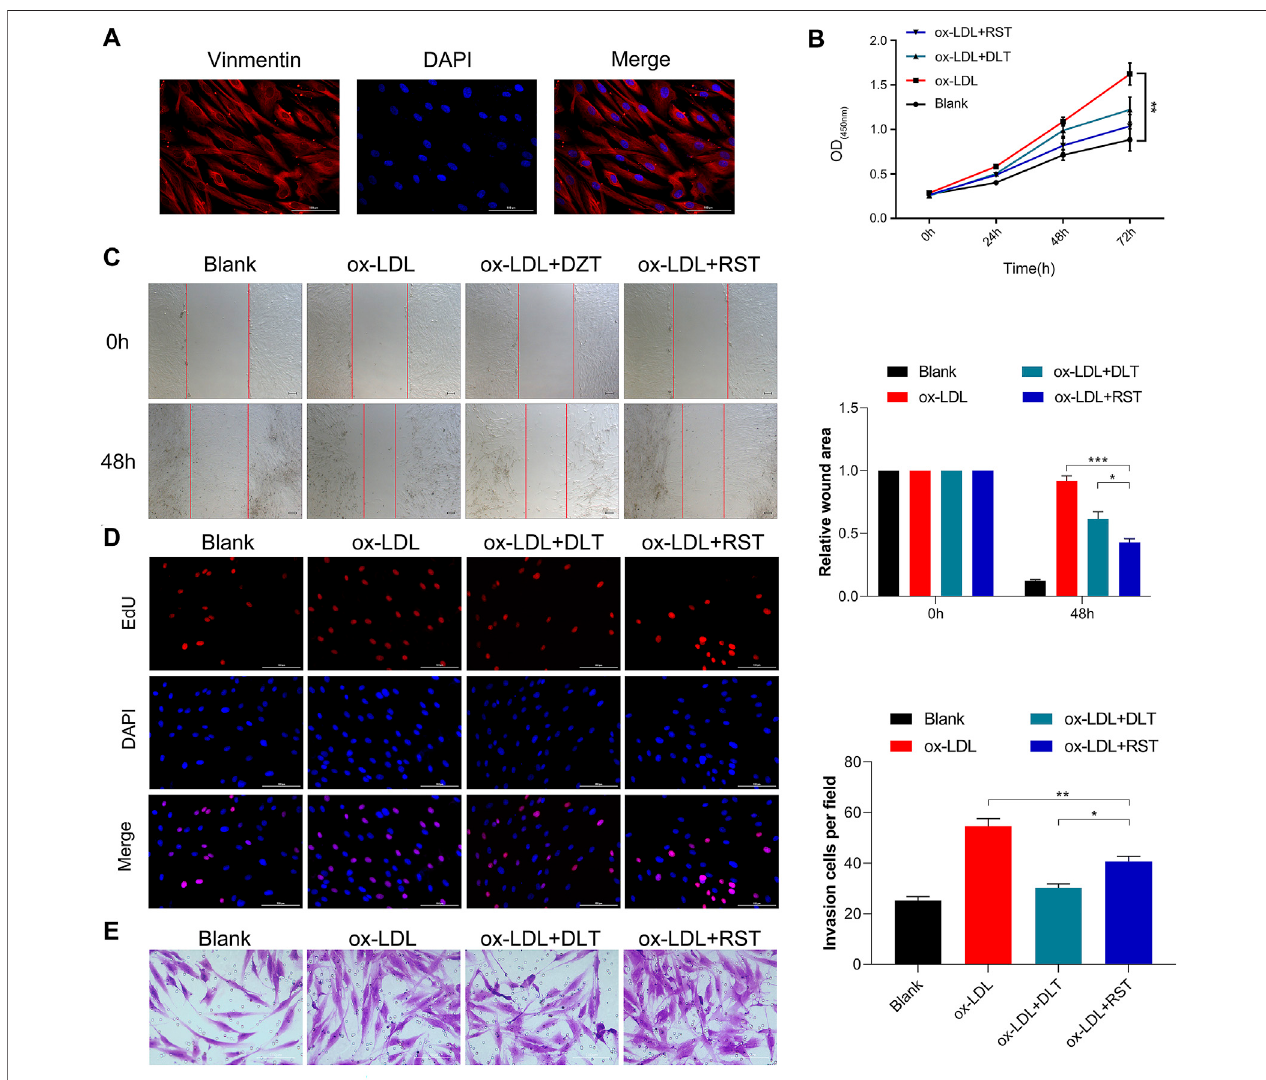
FIGURE3| DLTinhibitstheox-LDLeffectsintheHVAFline. (A) Vimentinstainingwasusedtoidentifythehumanvascularadventitial fi broblasts(HVAFs). (B,D) Cell proliferation was evaluated by CCK8 and EDU staining. (C, E) Wound healing and transwell assay showed the migration ability in the ox-LDL-induced model and DLT treatment group (* p < 0.05, ** p < 0.01, *** p < 0.001).